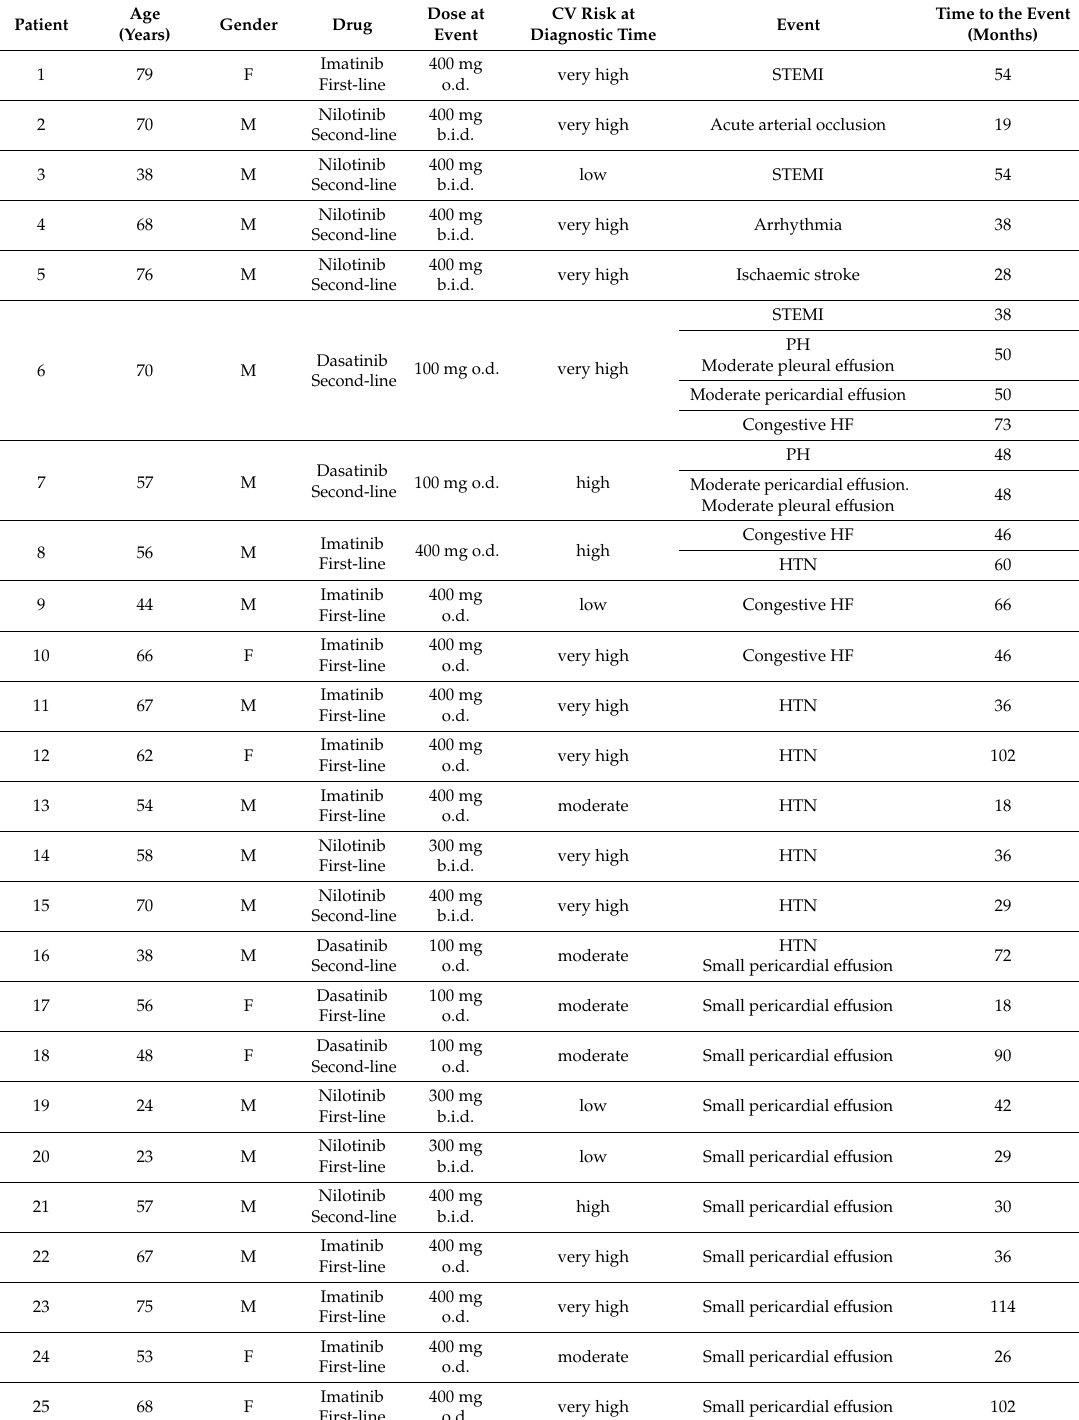
Table 6. Cardiovascular SCORE risk, cardiovascular, atherothrombotic events and e ff usions, in CML